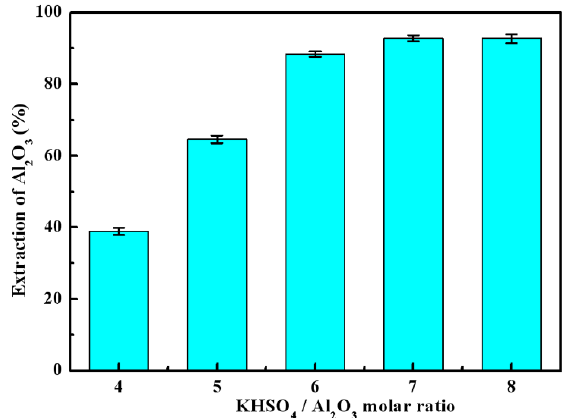
Figure 4. Effects of KHSO 4 /Al 2 O 3 molar ratio on alumina extraction from CFA at a calcination temperature of 230 °C and time of 3 h.